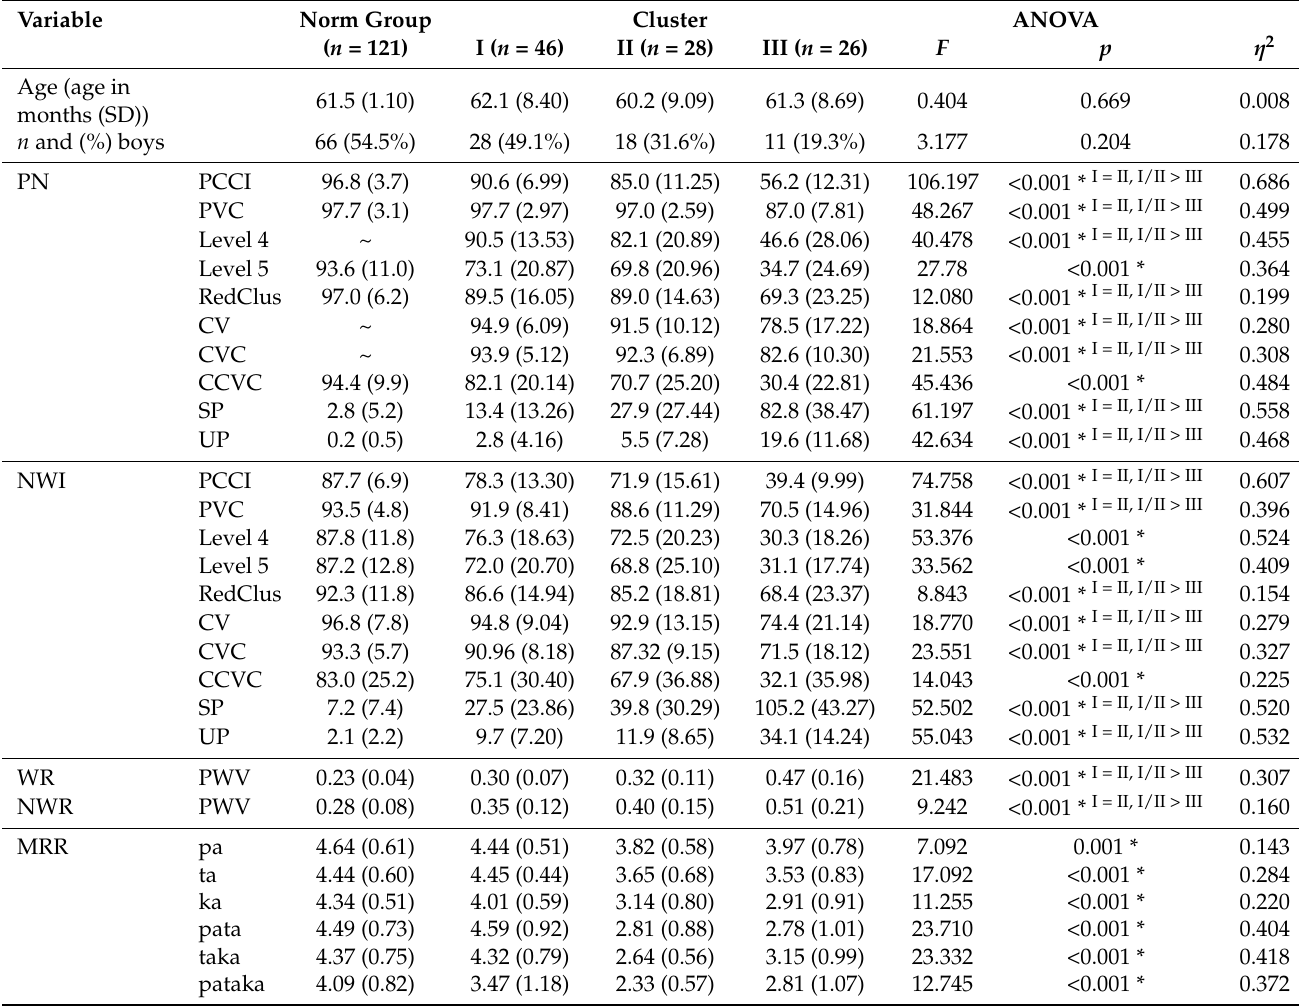
on all parameters. In Figure 2 the performance of the children on the tasks for the three clusters is shown. Table 4. Measures age, gender, parameters of the CAI in three subgroups of children with SSD identified by cluster analysis ( n =